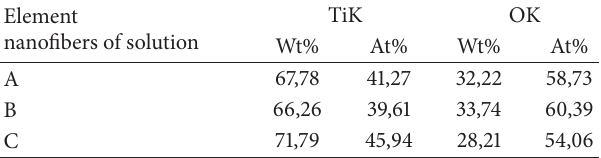
Table 2: Quantitative and qualitative analysis obtained by